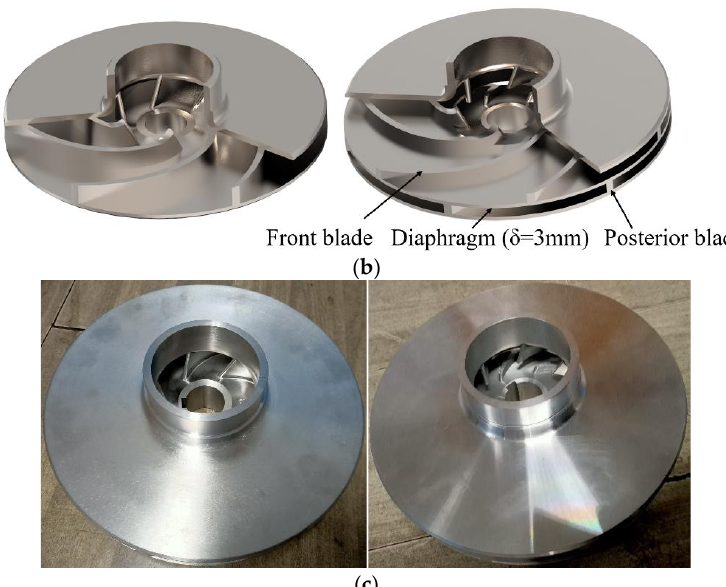
Figure 1. Original impeller and Staggered impeller. ( a ) Two − dimensional diagram of different impeller schemes; ( b ) Different blades scheme; ( c ) Tested impeller.